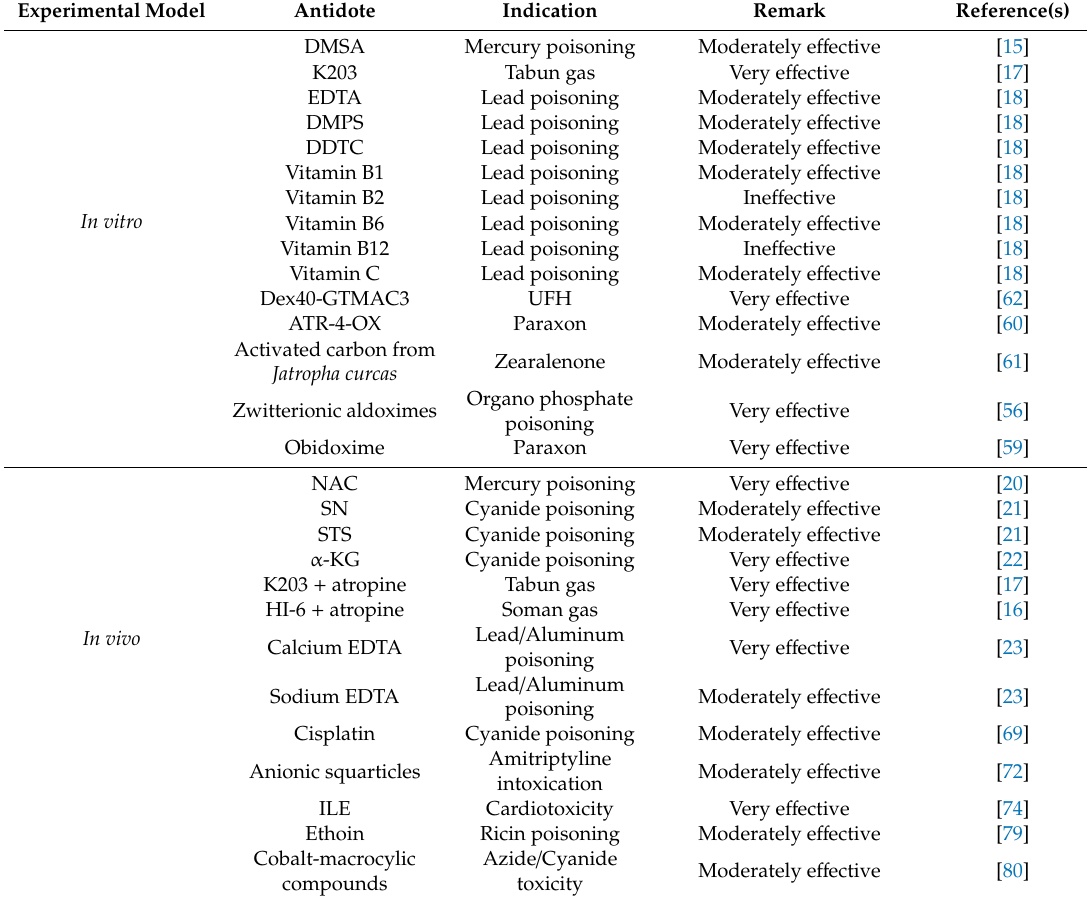
Table 2. Evidence of antidotes’ e ff ectiveness (selected) in vitro and in